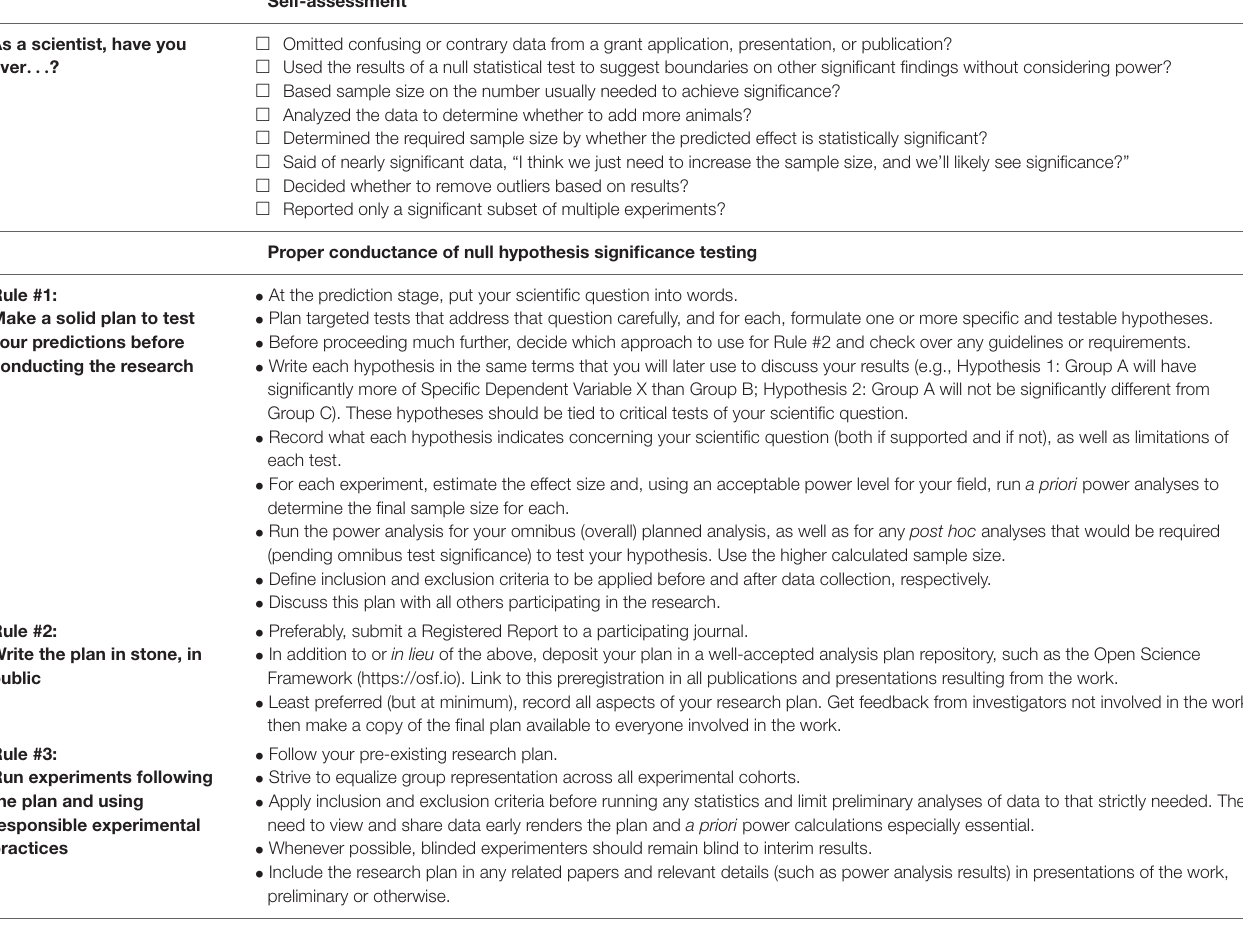
TABLE 1 | Self-assessment and rules to help protect against bias when conducting research with null hypothesis significance testing. Self-assessment As a scientist, have you ever ...